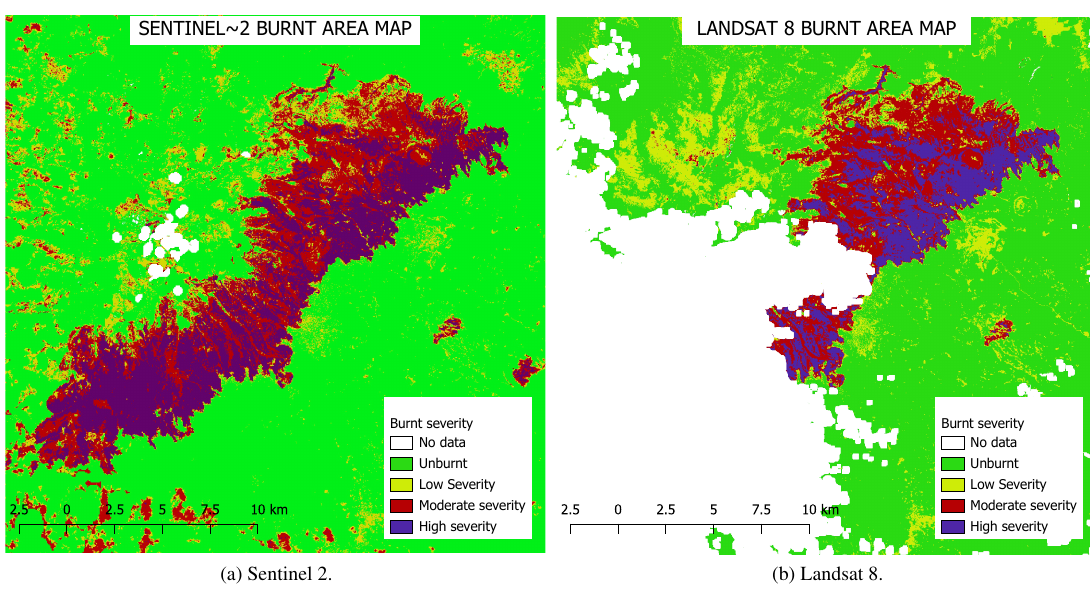
Figure 5. Mt. Kenya burnt area